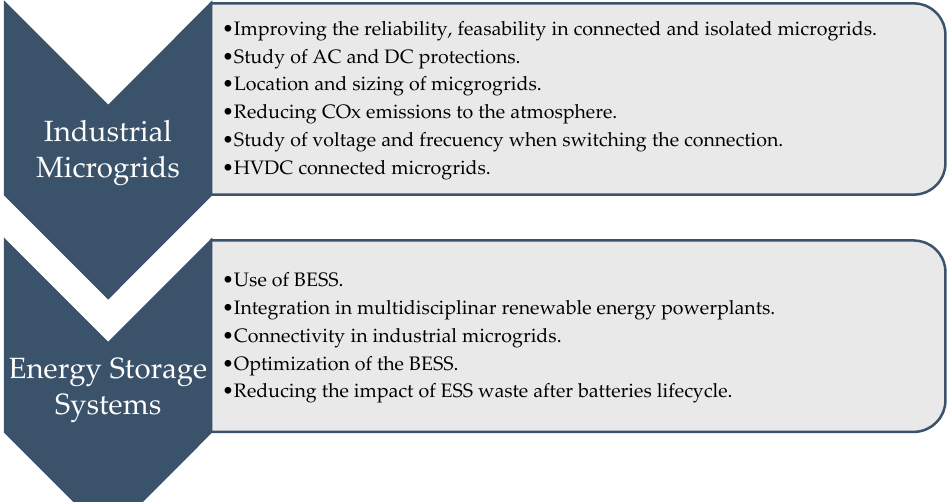
Figure 3. Possible trends and future research path regarding industrial MGs (source: own elabora- tion).